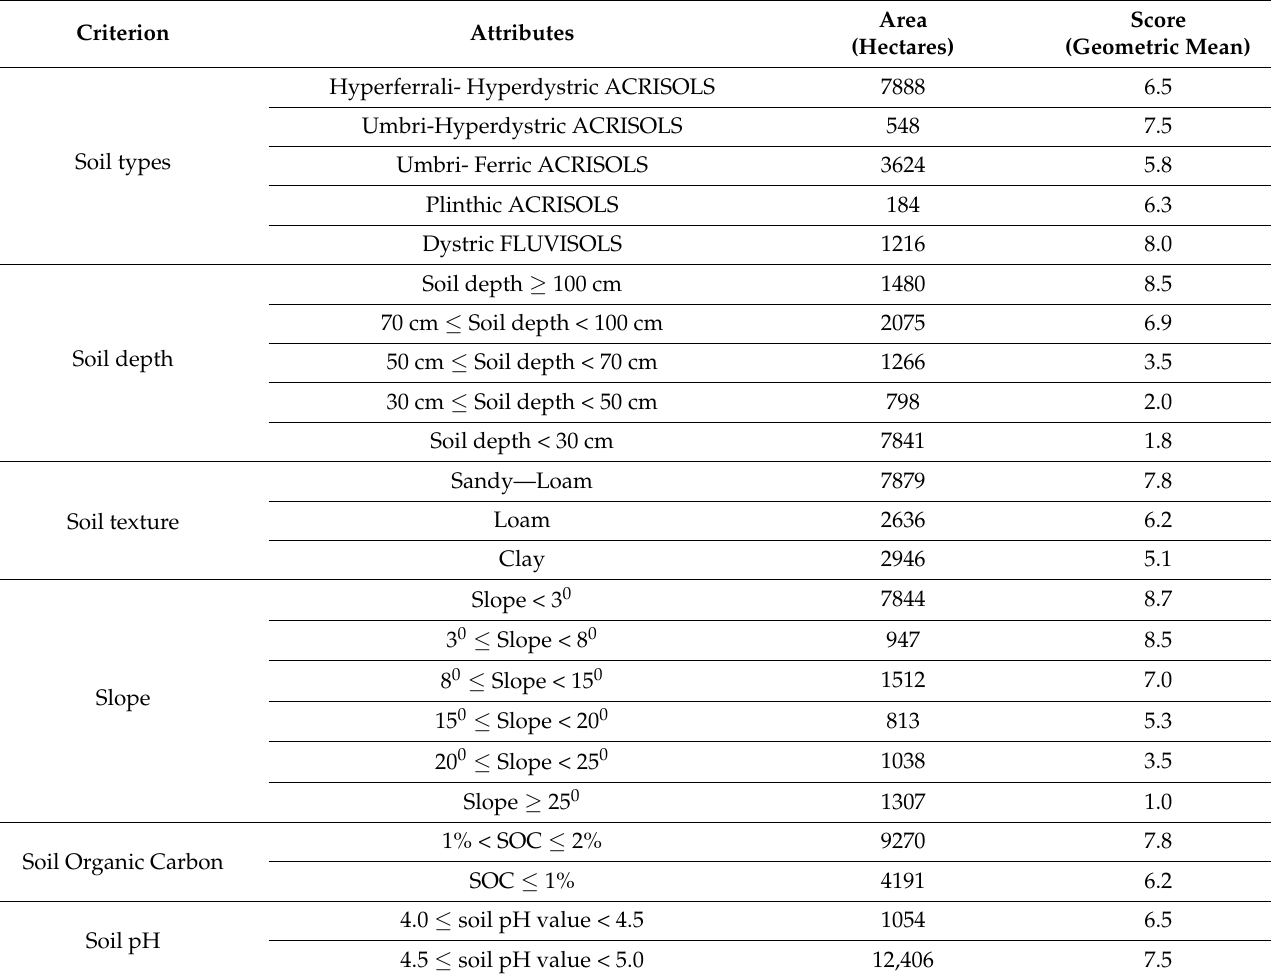
Table 5. Attributes of each criterion and its